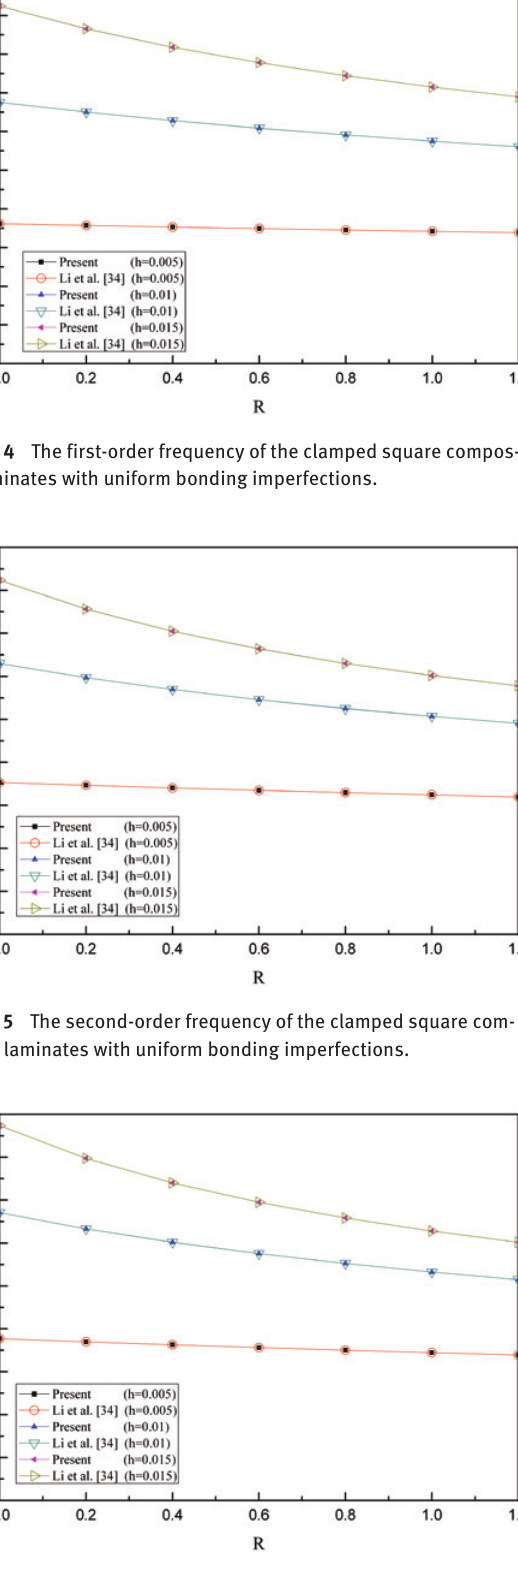
Figure 6 The third-order frequency of the clamped square compos- ite laminates with uniform bonding imperfections.